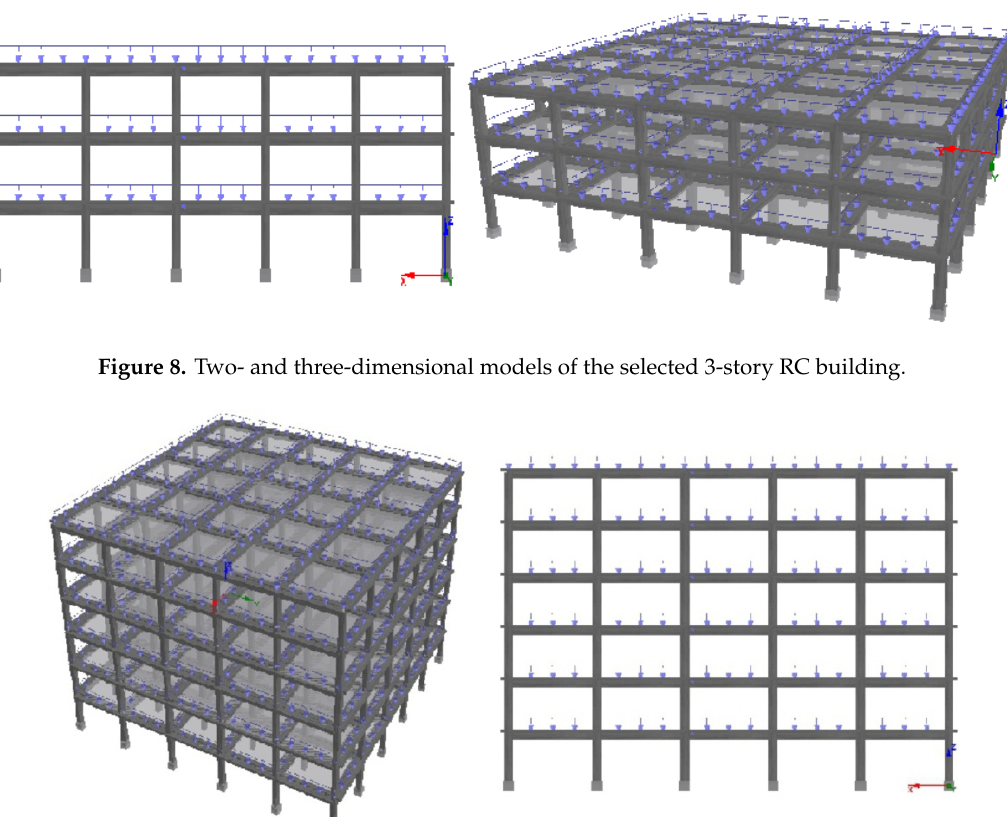
Figure 7. The blueprint of sample reinforced-concrete (RC) building.